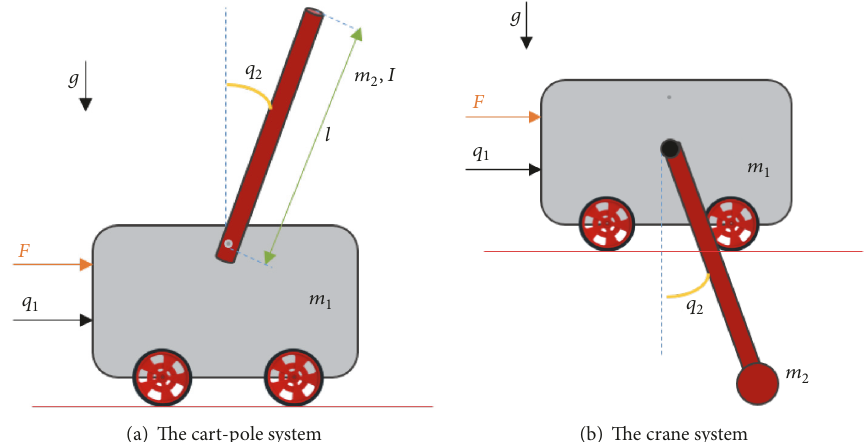
Figure 2: The 2 underactuated mechanical systems.